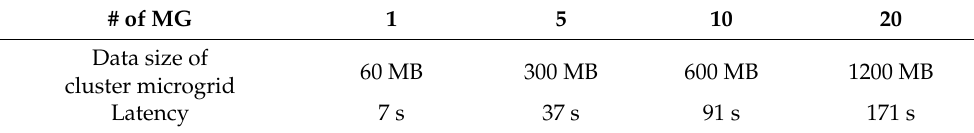
Table 4. Latency cluster microgrid through Large-scale distributed